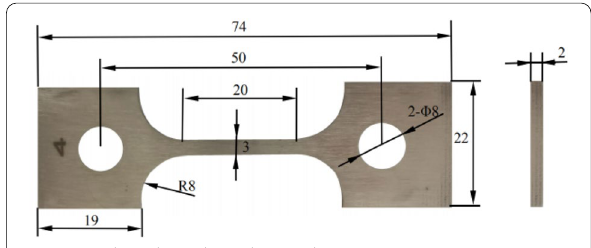
Figure 4 Plate-shaped tensile sample